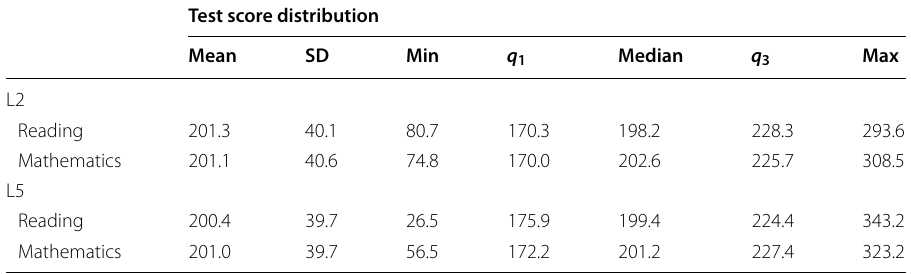
Table 1 Main summaries for students’ performance in reading and mathematics in second grade (L2) and fifth grade (L5)—school year